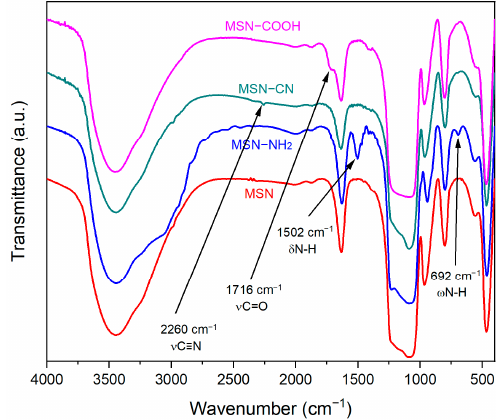
Figure 4. FTIR spectra of MSN supports.